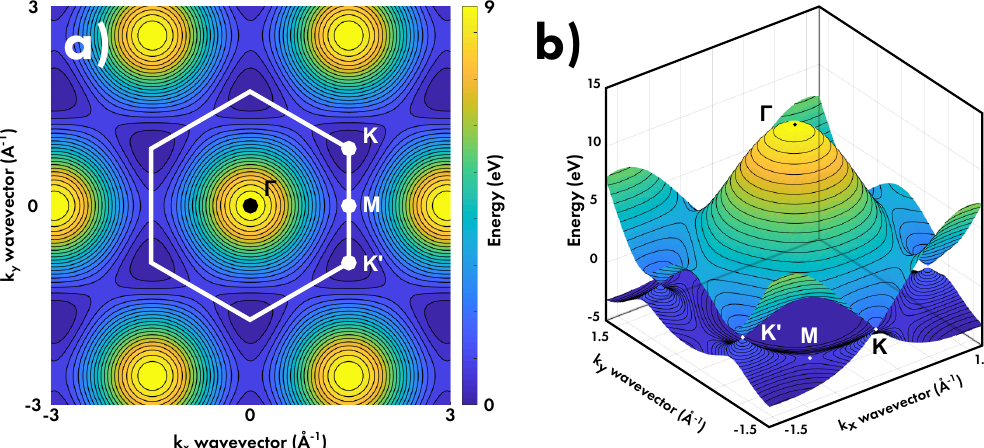
Figure 9. 2D ( a ), and 3D ( b ) surface plots of graphene energy bands for finite values of coefficients in Equation (19) equal to t = 2.7 eV and s = 0.2 t and (cid:101) 2p the first Brillouin zone (white hexagon) are marked by